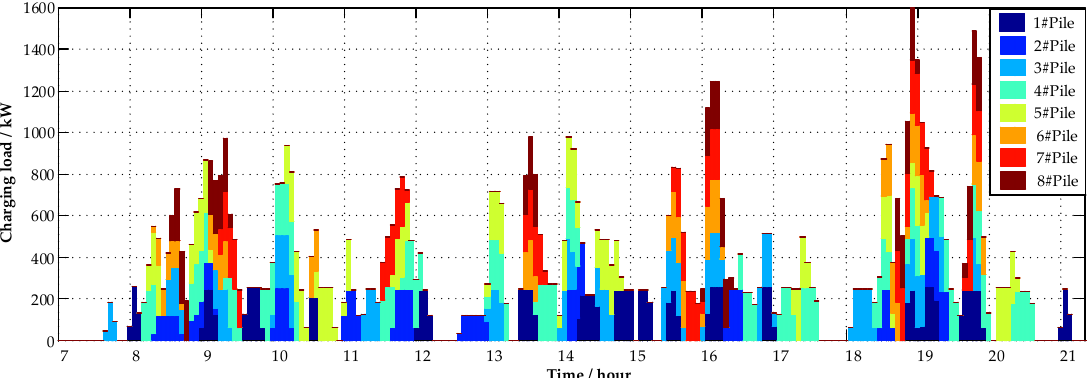
Figure 2. Realistic charging loads of each pile in one PEB fast charging station.